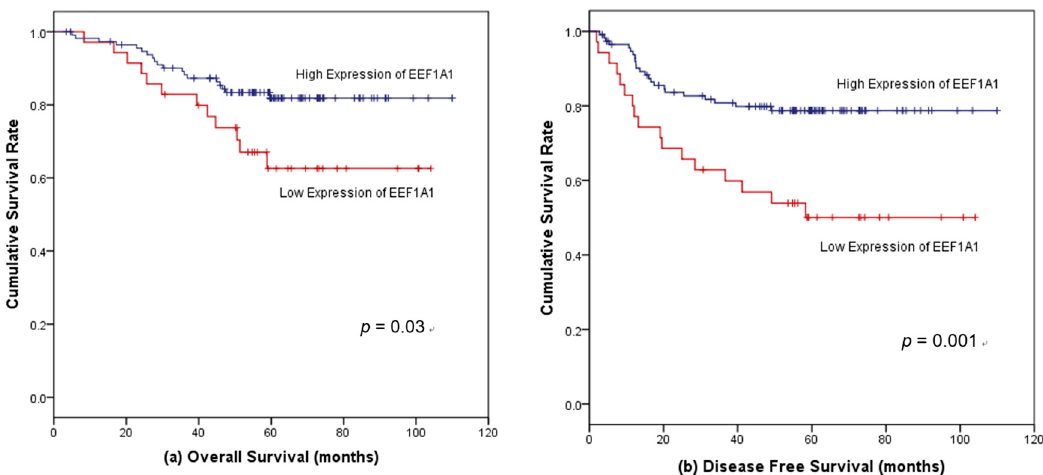
Figure 4. Kaplan–Meier survival curves according to EEF1A1 protein expression in stage III colon cancer patients. ( a ) High EEF1A1 expression was significantly associated with favorable overall survival (OS) and ( b ) disease-free survival (DFS).